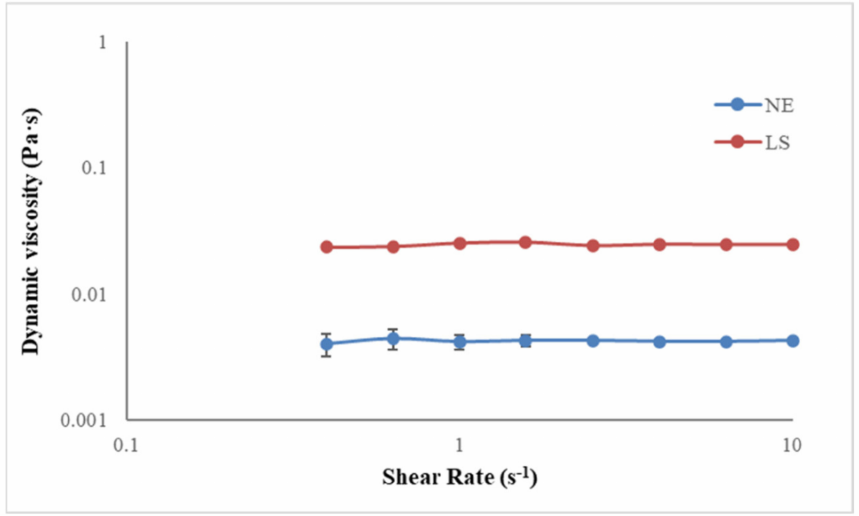
Figure 3. Dynamic viscosity test for NE and LS